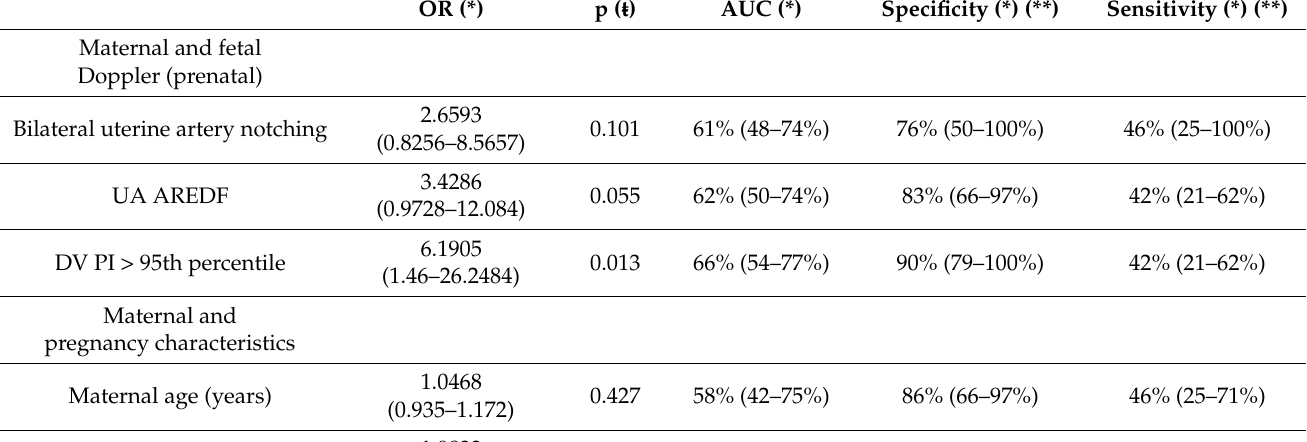
Table 3. Predictivity of parameters according to nominal logistic regression followed by ROC analysis for univariate